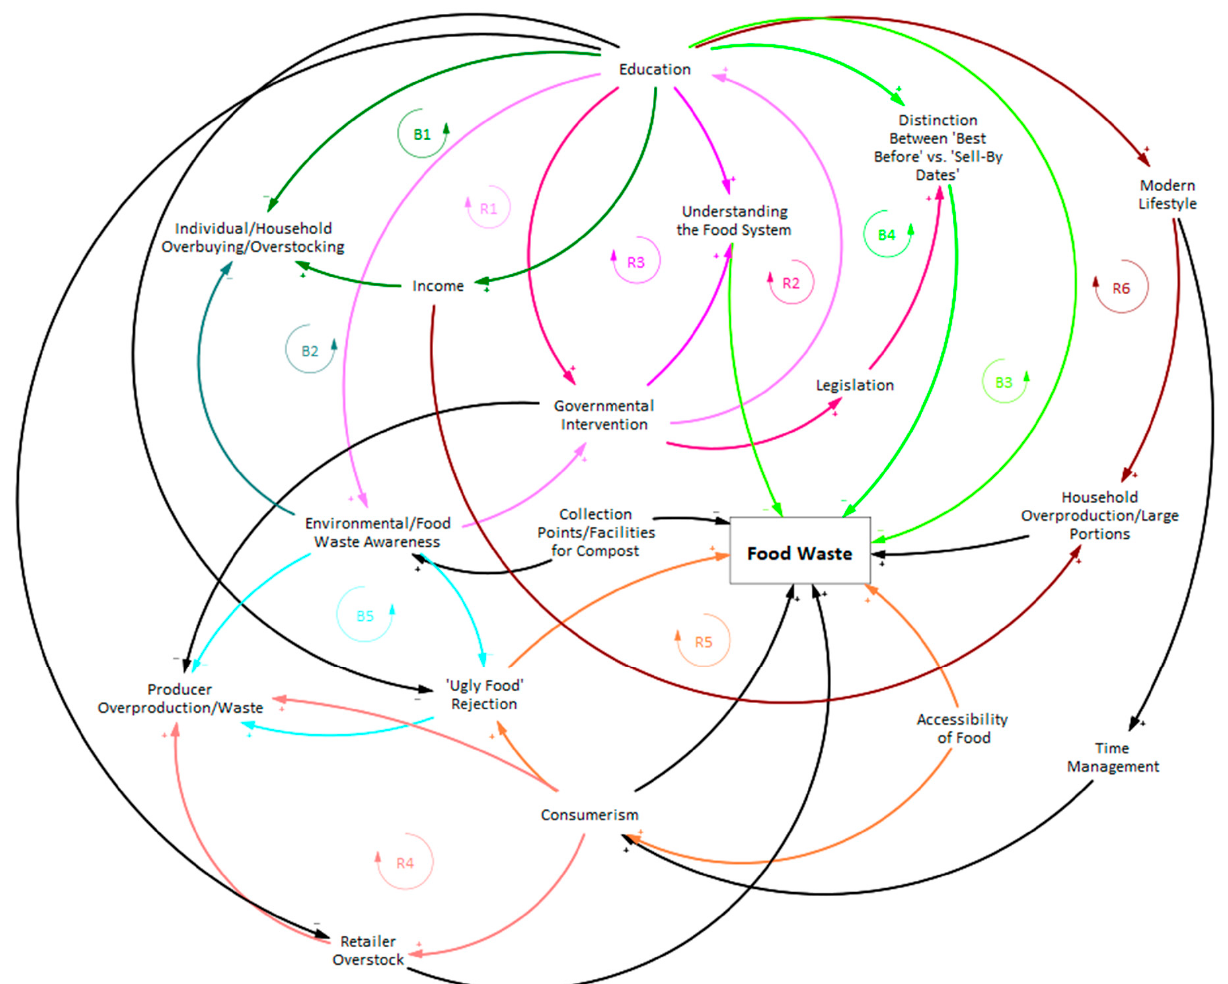
Figure 1. Food waste loop diagram, including the variables and their relations mentioned during multiple modeling sessions (each color highlights a distinct loop).